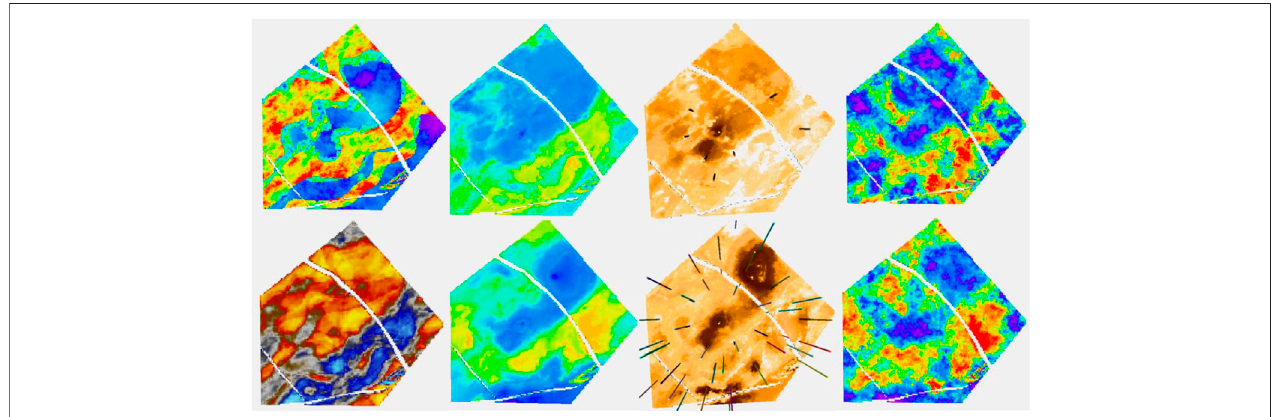
FIGURE11| Emberresultsforablindwell,circledinred.Twolayersareontheleft,oneinchannelsandandtheotherintheshoreface.Theirdepthlocationsonthe well track are shown with arrows. Tracks are, from left, true porosity of the blind well; prob (poro > 15%); the next fi ve tracks are simulations; true porosity (red) superimposed on envelope; and